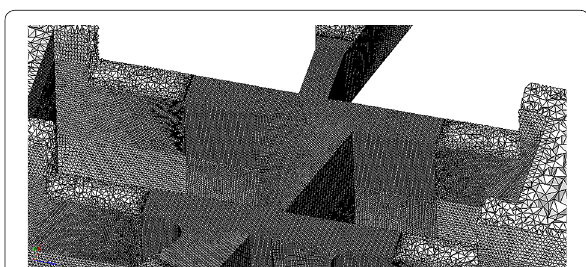
Figure 9 Critical parts mesh generation